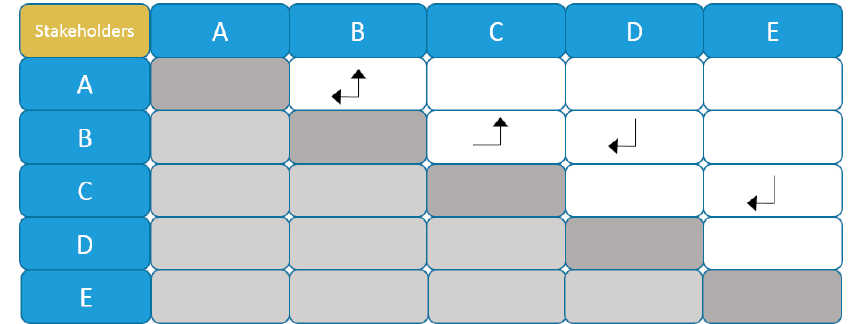
Figure 7. Example of matrix of influences between 5 stakeholders (A, B, C, D and E). A and B influence each other, B influences C, D and E influence B and C respectively. Dark grey cells do not apply (A does not influence A) and light grey cells would be repeating the relationship in white cells (example AB = BA).